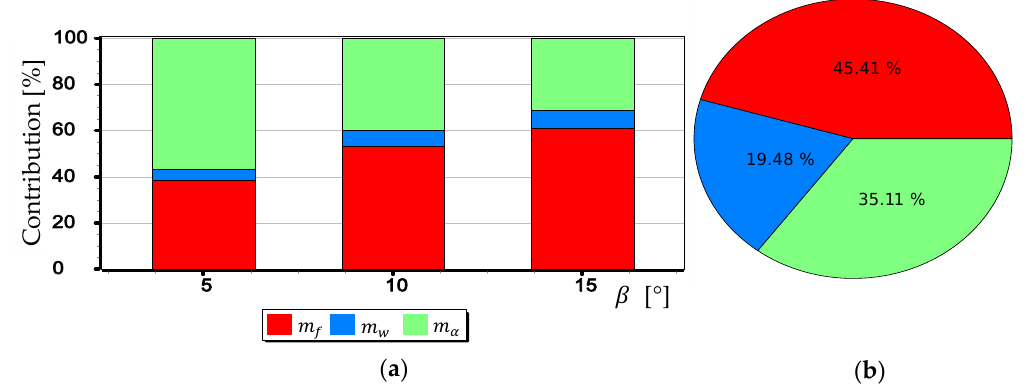
Figure 28. Percentage contribution for DIJ FC220 camera: ( a ) Calculated for 𝛽 equals 5°,10° and 15° ; ( b ) Calculated as a mean value. Sensors 2019 , 19 , x FOR PEER REVIEW